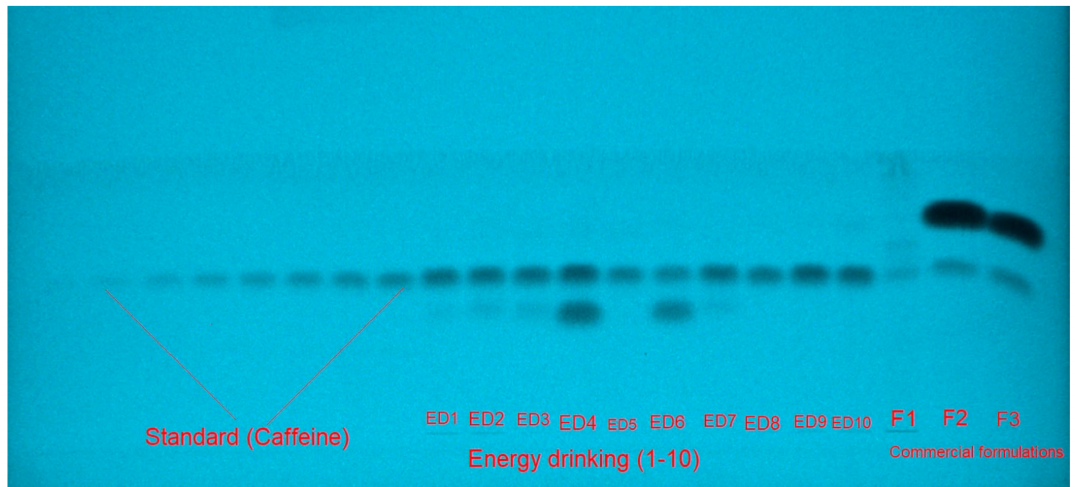
Figure 1. Developed plate for standard caffeine, various energy drinks (ED), and commercial formulations established using EtOH-water (55:45, v v − 1 ) combination for the green high-performance thin-layer chromatography (HPTLC)